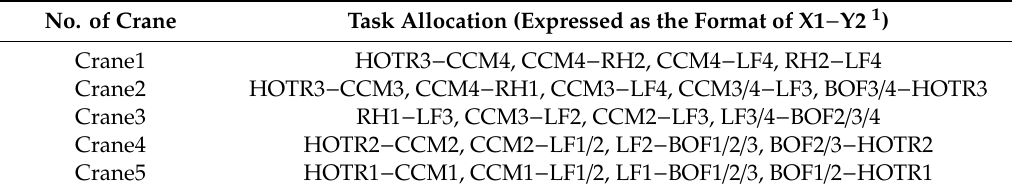
Table 3. Task allocations for cranes in tapping span.